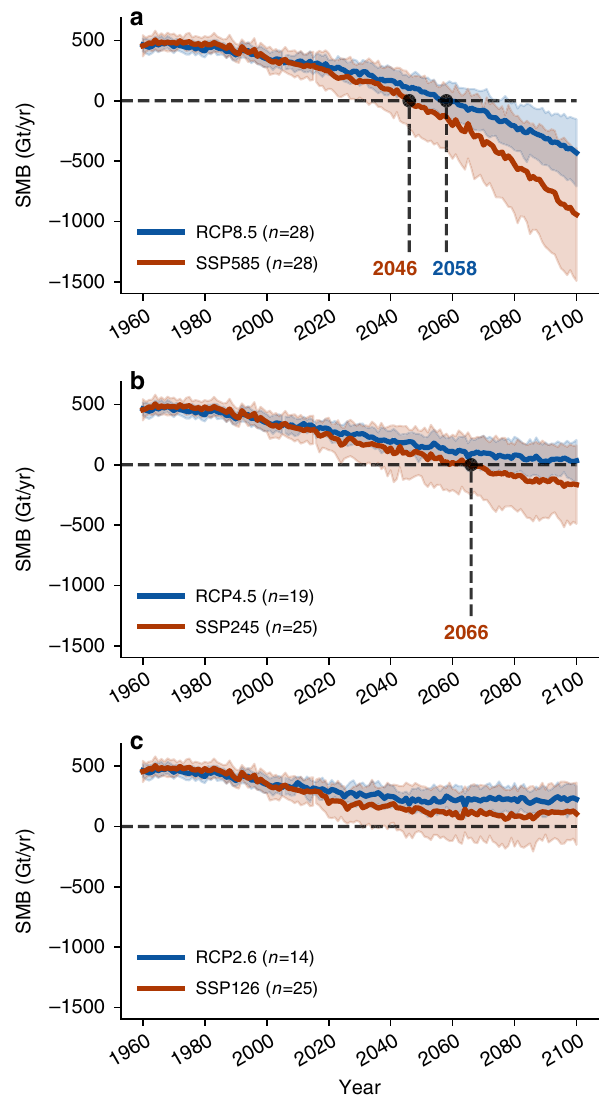
Fig. 5 Reconstruction of the Greenland Ice Sheet surface mass balance across all CMIP5 and CMIP6 emission scenarios. a Annual Greenland Ice Sheet surface mass balance (Gt/yr) for the CMIP5 and CMIP6 extreme high-emission scenarios (RCP8.5 and SSP585), reconstructed with the individual equations found in Fig. 4c). The orange and blue numbers denote the years in which the mean SMB of the CMIP6 and CMIP5 ensemble drops below 0 Gt/yr, the colored lines represent the ensemble mean, the shaded areas cover ±1 SDs around the mean. The size of the ensemble is given in the fi gure legend (e.g., n = 28). b Same as a but for the RCP4.5 and SSP245 scenarios. c Same as a and b but for the low-emission scenarios RCP2.6 and SSP126.